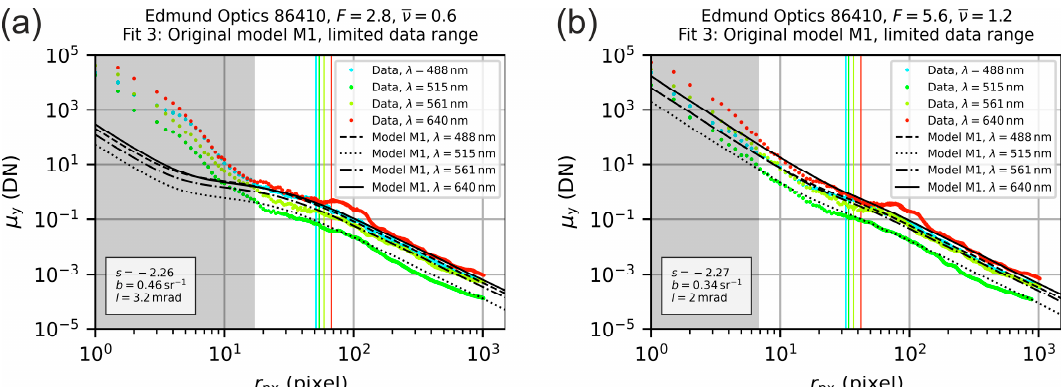
Figure 15. Radial irradiance distribution for the lens Edmund Optics 86410 operated with an f-number of ( a ) 𝐹 = 2.8 and ( b ) 𝐹 = 5.6 . The colored points are the measured values derived from the analysis of the camera images. The black lines are the result of fitting the theoretical model M1 to the data within a limited range of the radial coordinate (excluded data is shaded in gray).